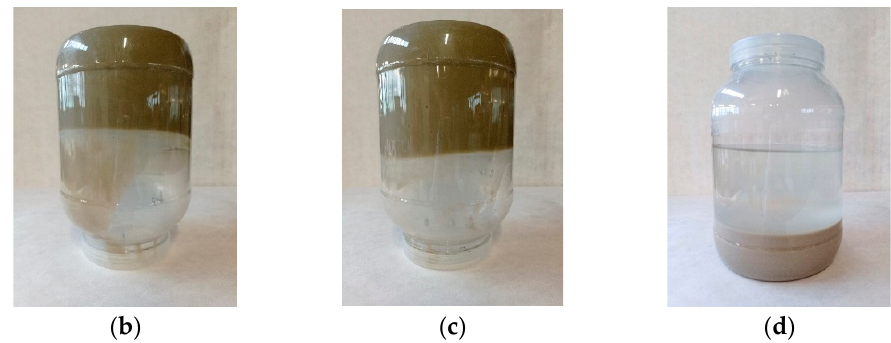
Figure 1. 12% water solution of bentonite: ( a ) GM, ( b ) Special, ( c ) Special 45, and ( d ) SN 30 min after production. Table 9. Physical parameters of the produced samples of suspension